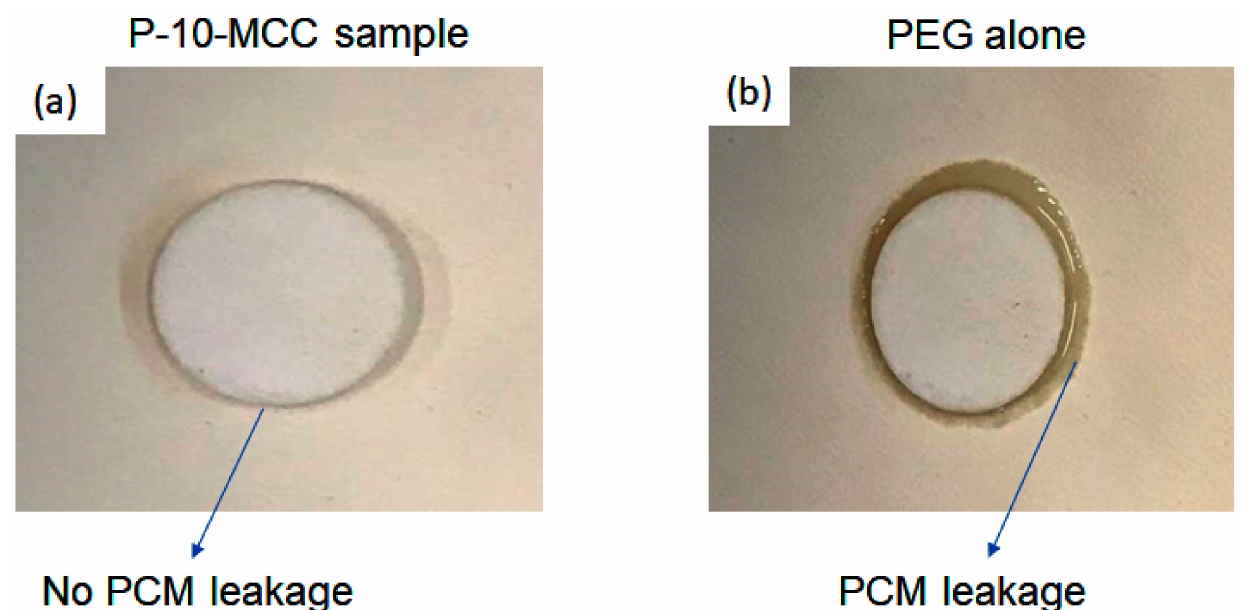
Figure 13. Photographs of ( a ) P-10-MCC ( b ) PEG alone after being heated at 70 ◦ C for checking leakage (seepage